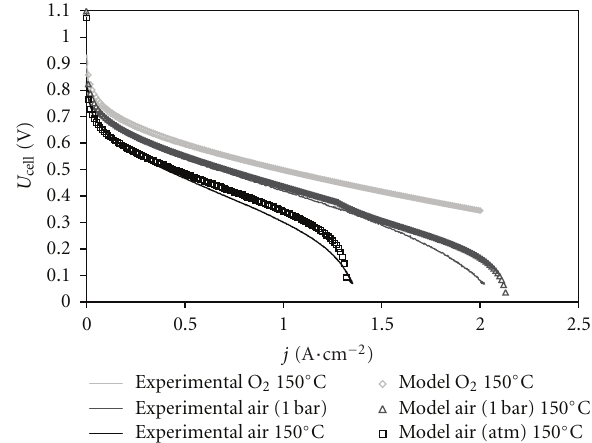
Figure 4: Comparison between modelled and experimental results for HT-PEMFC utilising 50% Pt/C at the cathode and 20% Pt/C on the anode at temperature of 150 ◦ C and various pressures; alpha value of 0.75 was used for the